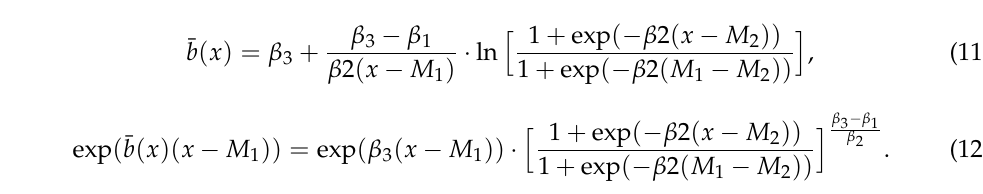
Table 6. Parameters and functions assigned in the general model of q ( x )